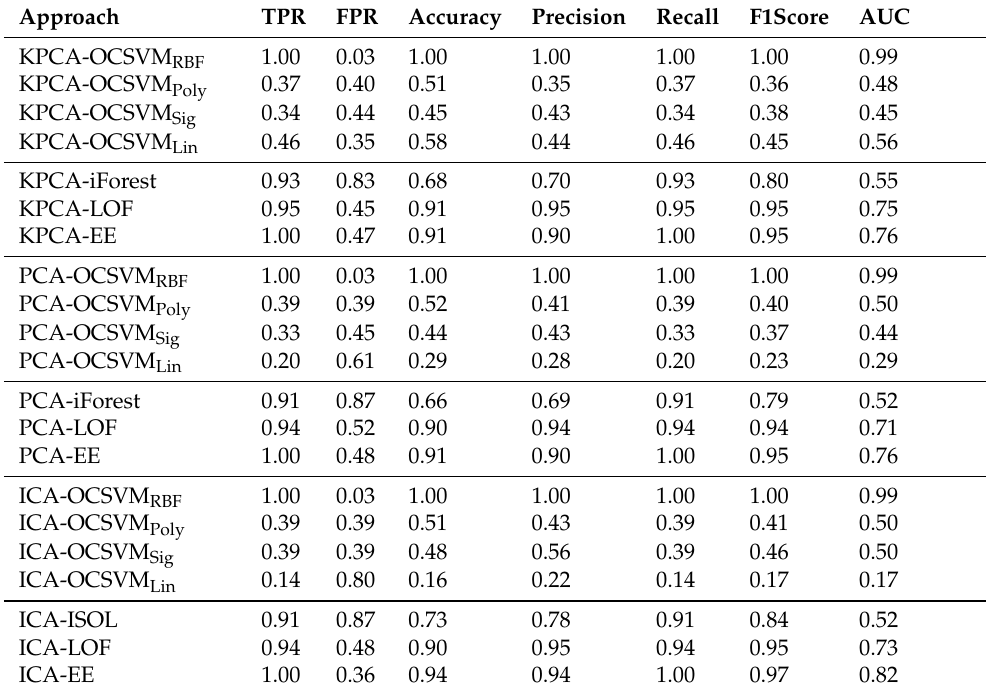
Table 4. Detection results based on testing data in Dataset